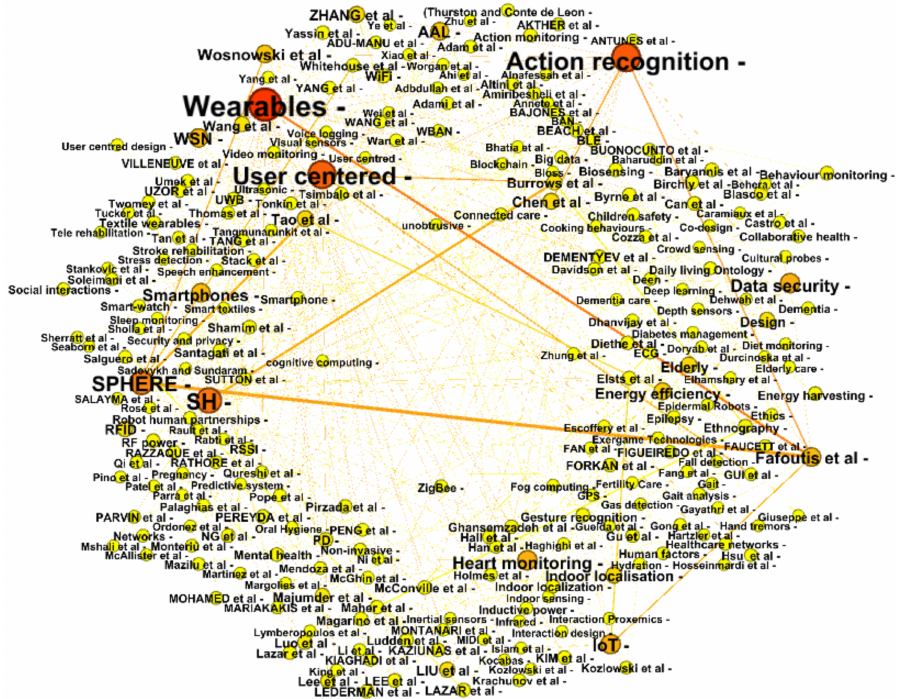
Figure 3. Visualization showing authors’ relationships with key